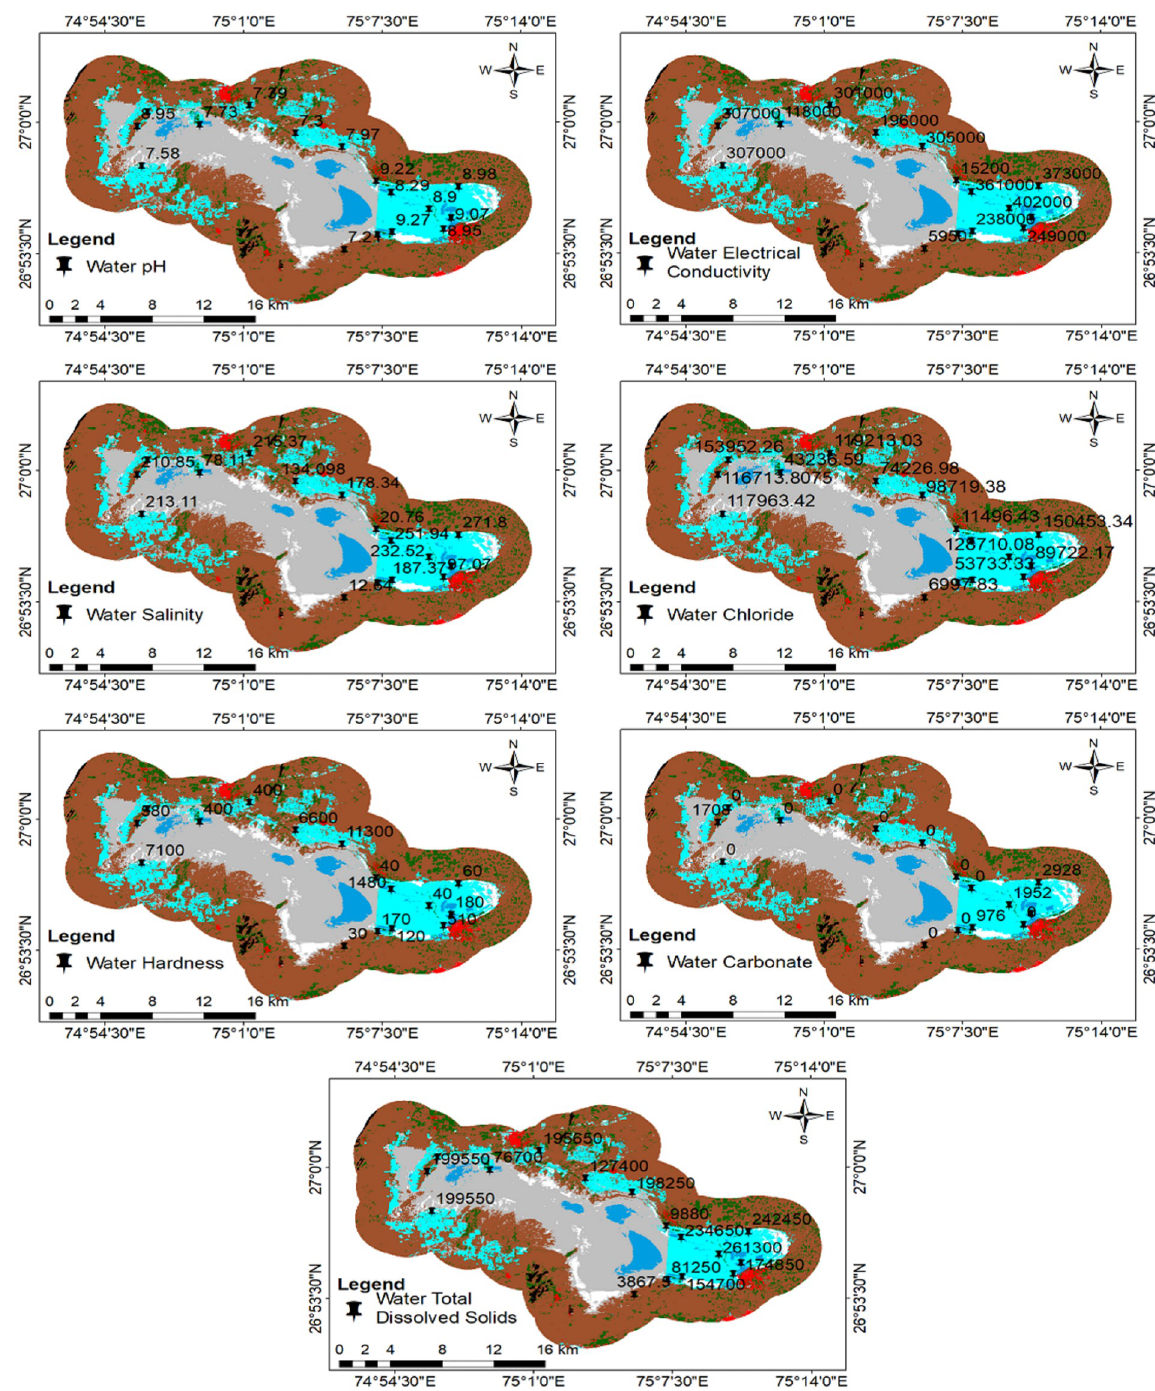
Fig 8. Mapping water quality